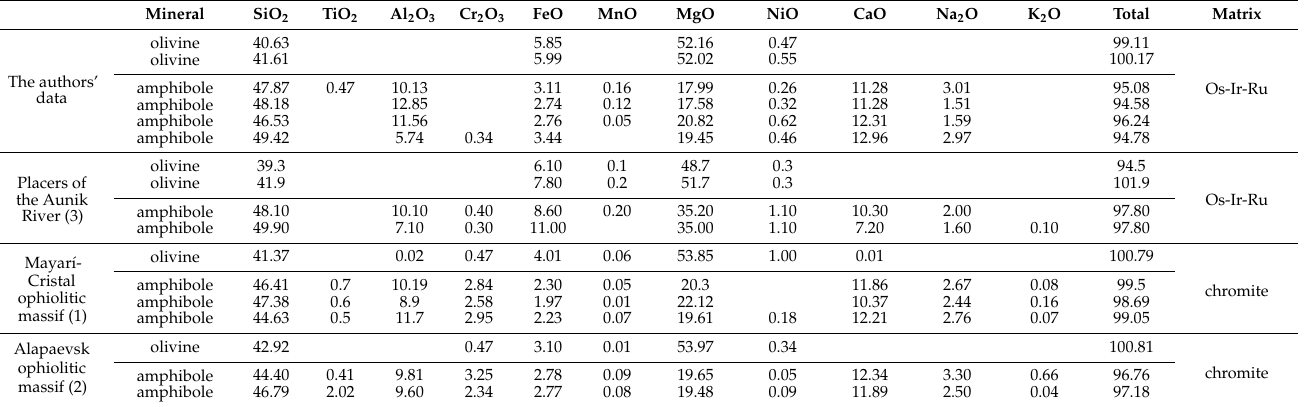
Table 2. Chemical composition of the silicate inclusions in the PGM of the Kitoy River according to the EDS data (wt.%) compared to the silicate inclusions in the chromian spinel from different ultrabasic-basic complexes